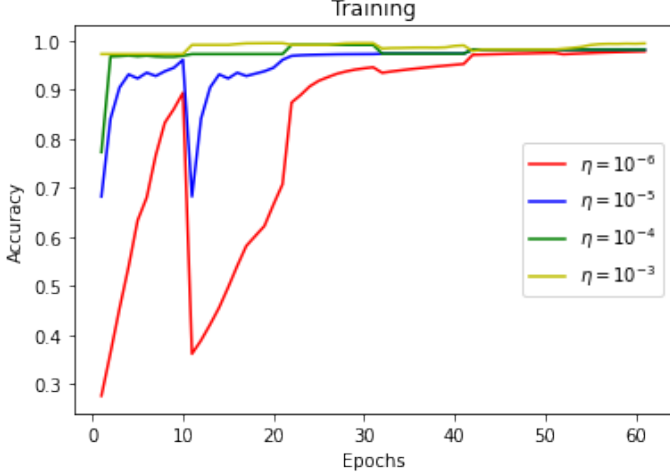
Figure 14. Training Accuracy with Different Learning Rates.